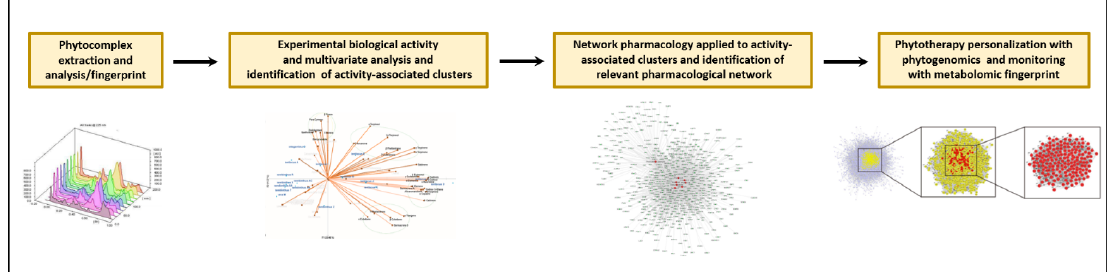
Figure 3. Proposed workflow for molecular characterization, pharmacological activity, and therapeutic application of essential oils phytocomplex: from single molecules analysis to multivariate approaches and network pharmacology to phytogenomic personalization.